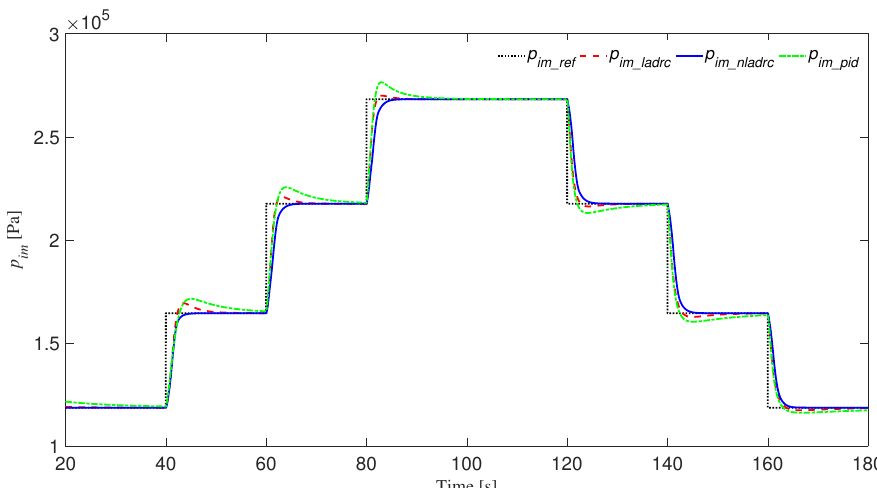
Figure 13. The response curve of intake manifold pressure under different fuel injection conditions.